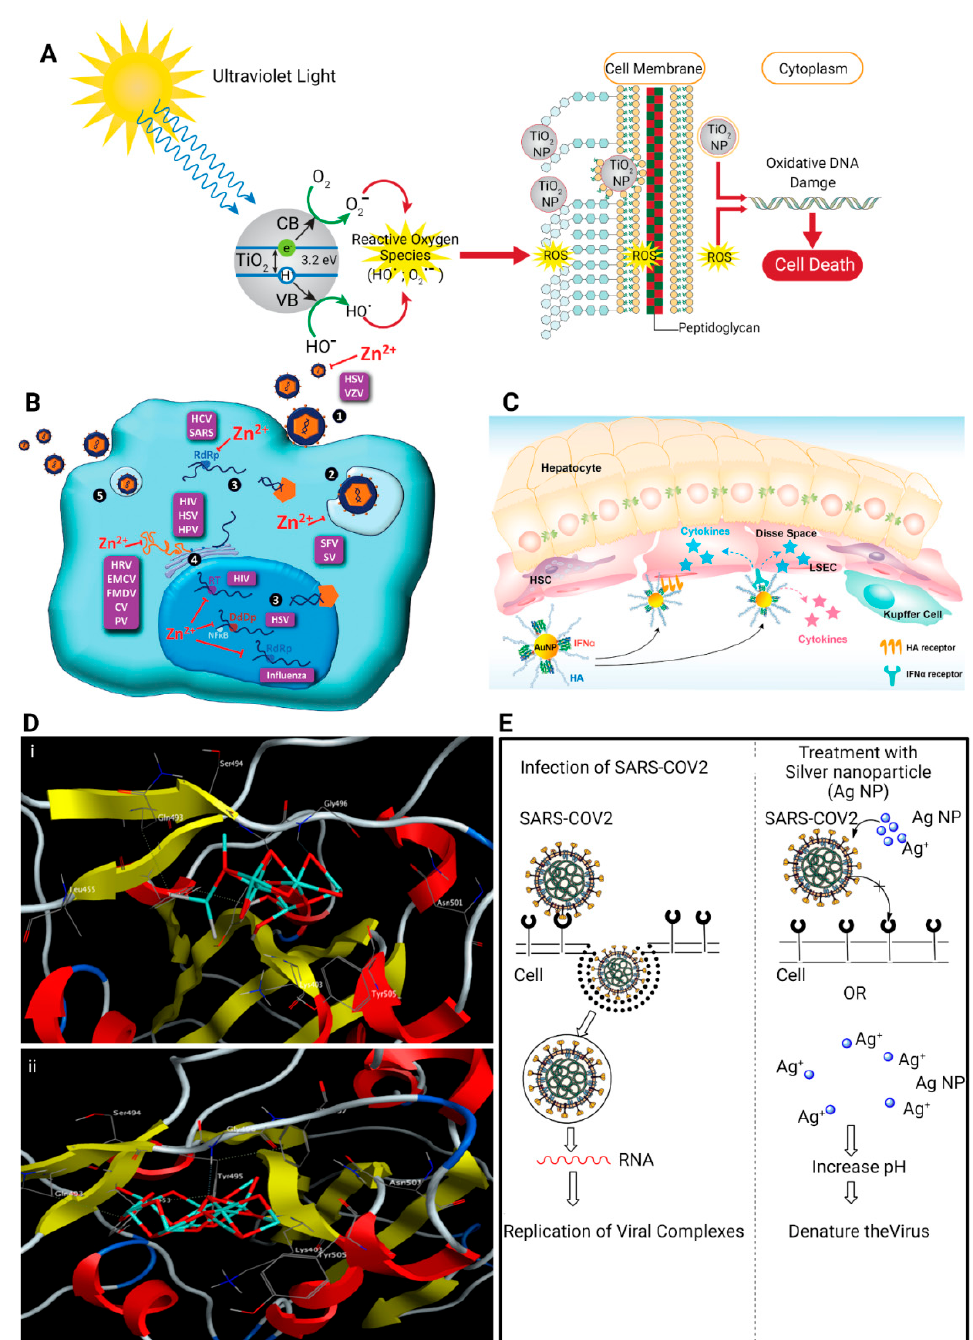
Figure 7. Schematic of the antiviral mechanism of inorganic nanoparticles. ( A ) The antiviral activity of TiO 2 nanoparticles is attributed to the formation of reactive oxygen species. Reprinted from [176] with permission from Elsevier, ( B ) Antiviral activity of Zn nanoparticles is attributed to the inhibition of viral genome transcription, viral protein translation, and polyprotein processing. Reprinted from [178] with permission from American Society for Nutrients, ( C ) Strategic illustration of HA-AuNP/IFNR complex for the target-specific systemic treatment of hepatitis C infection. Reprinted from [180] with permission from American Chemical Society, ( D ) 3D interaction schematic showing (i) Fe 2 O 3 and (ii) Fe 3 O 4 docking interactions with the key amino acids in the receptor- binding domain of the spike protein (S-RBD) of SARS-COV-2. Reprinted from [182] with permission from Elsevier, ( E ) The proposed antiviral mechanism of Ag nanoparticles against SARS-CoV-2. Reprinted from [183] with permission from Multidisciplinary Digital Publishing Institute. Table 1. An overview of the antiviral mechanisms of multivalent nanomaterials.